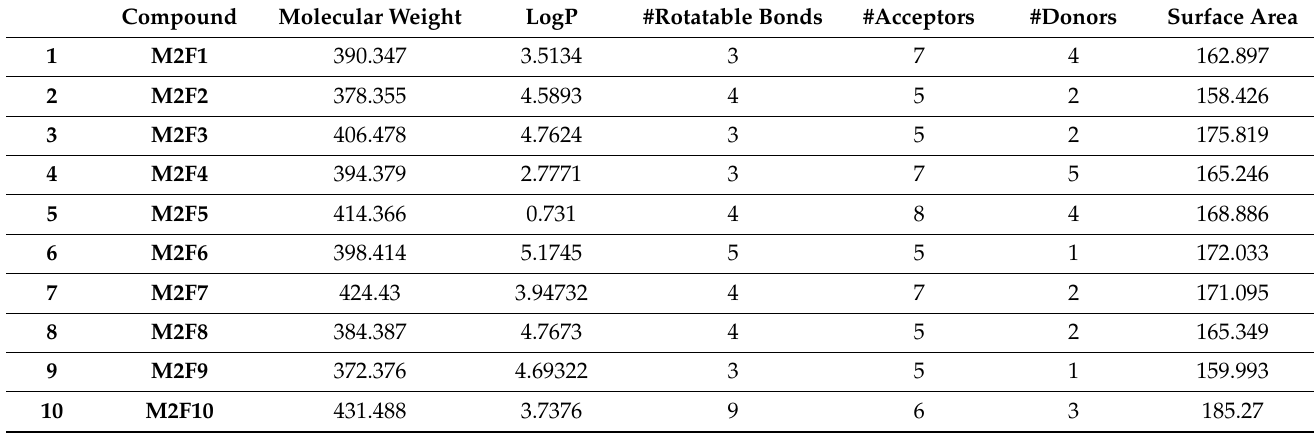
Table 3. Structures and chemical properties of the selected flavonoids against MEK2.